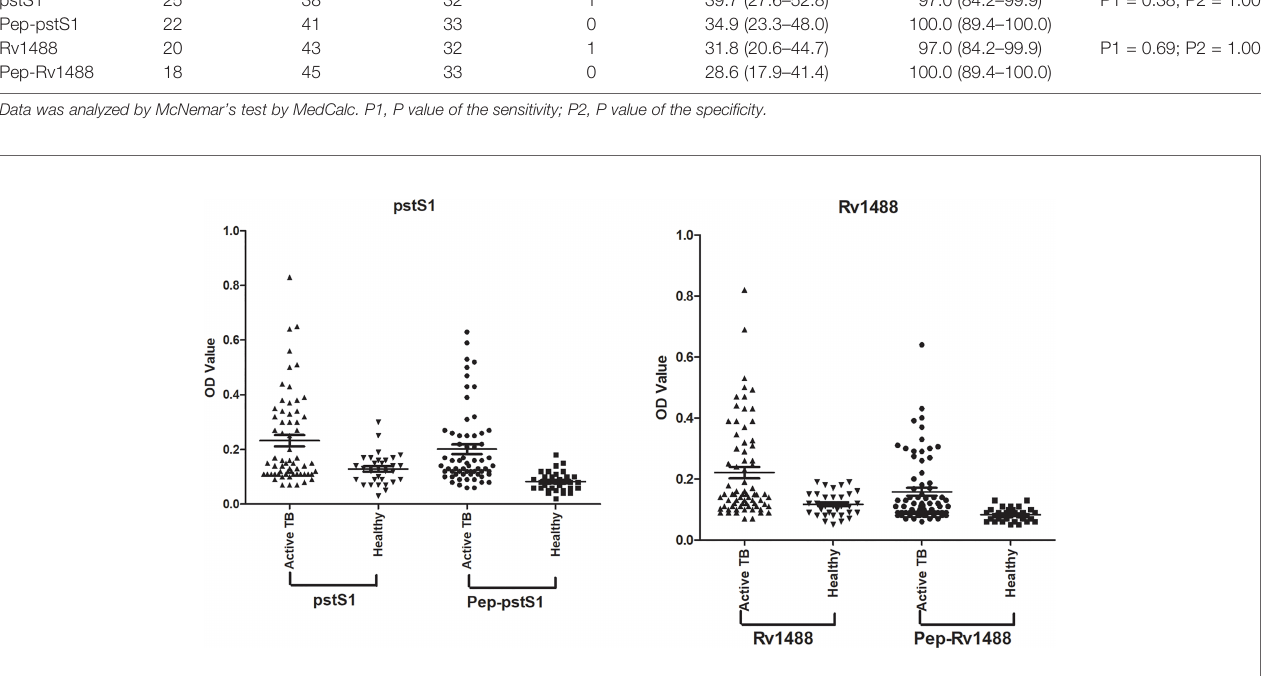
FIGURE 3 | Comparison of the differences of sensitivities and speci fi cities between polypeptides and their corresponding antigens. A panel of 96 serum samples, including 63 TB patients and 33 healthy individuals, was collected to compare the differences between Pep-PstS1 and Pep-Rv1488 and their corresponding